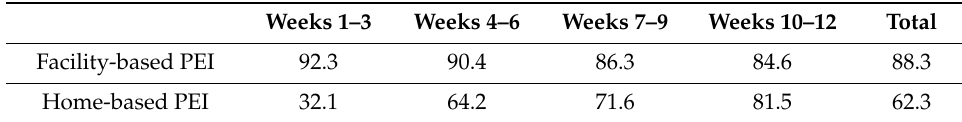
Table 3. Adherence rate (%) calculated at 3 week